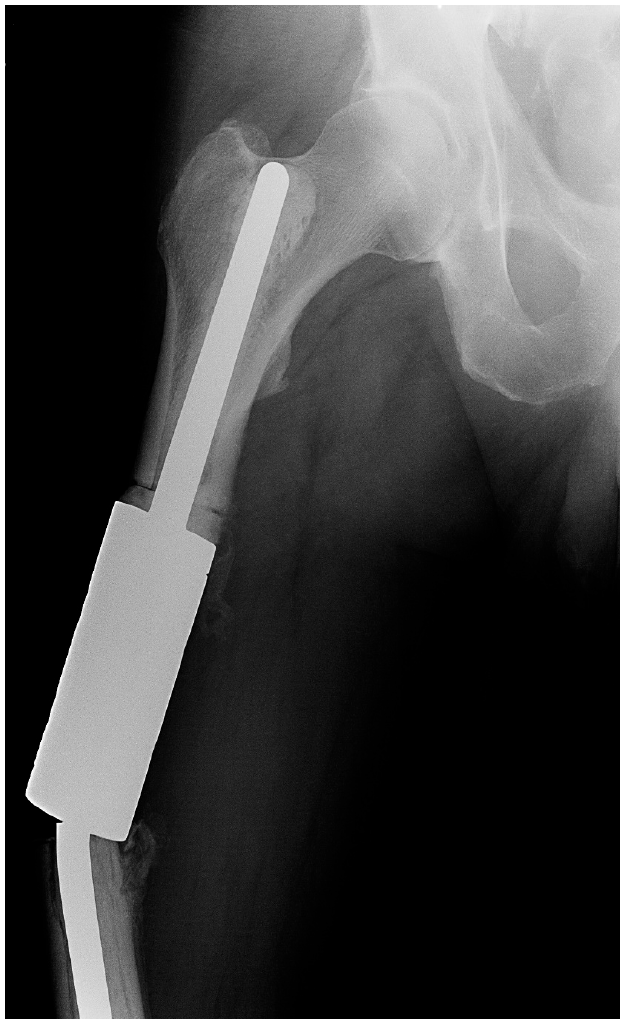
Figure 4. X-ray image of a fracture at the clamp-rod interface (type III failure) of an individual femoral diaphyseal implant for renal cell carcinoma oligometastatic disease. Revision intercalary endoprosthesis was performed. This image is from patient 8 in Table 1.